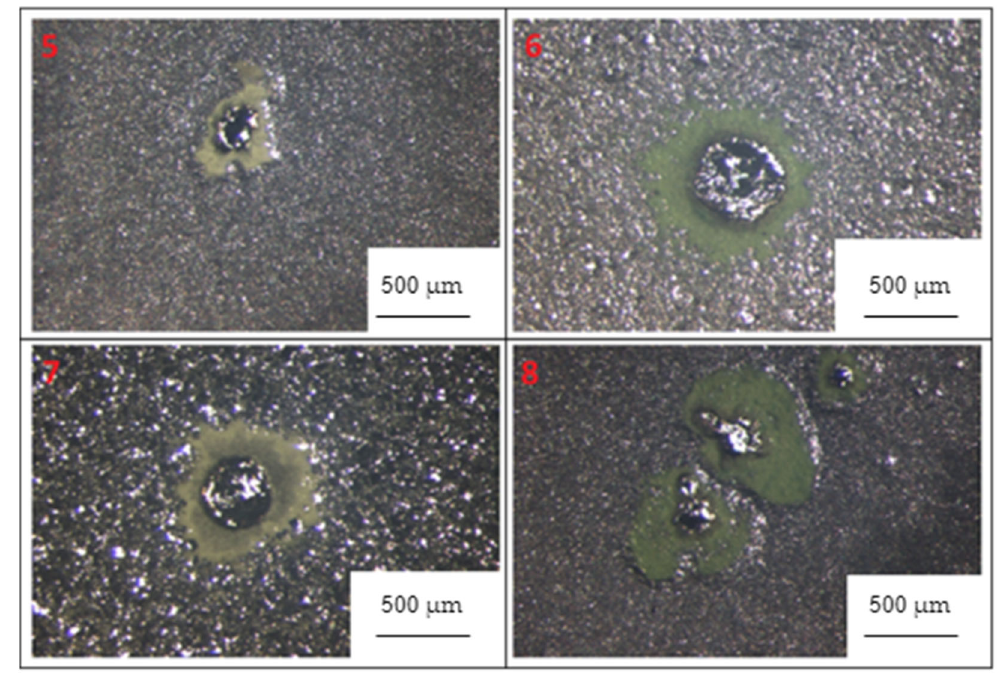
Figure 7. Damages of samples by electric discharge 5–8 (sorted following Table 3).